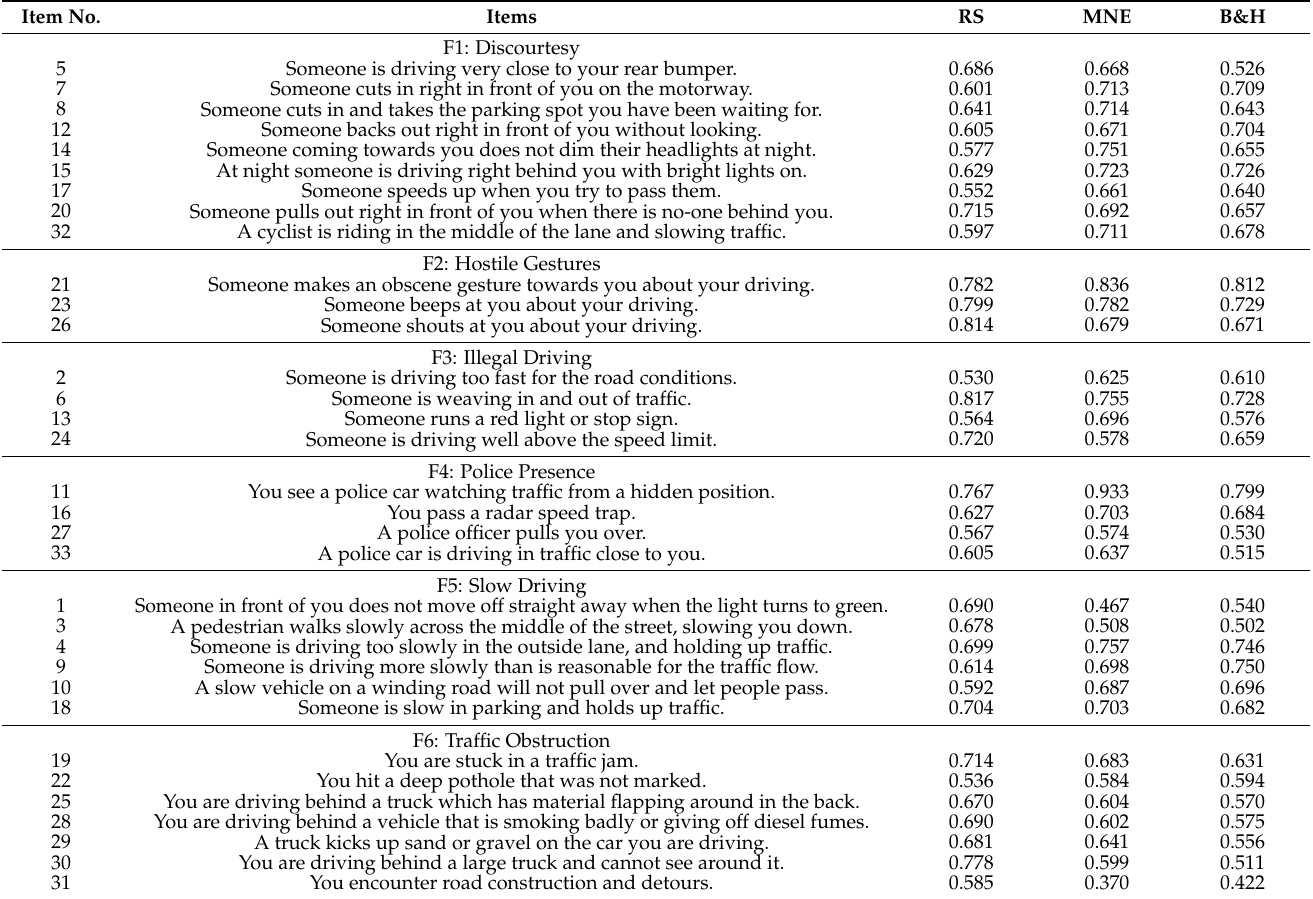
Table 4. Standardized factor loadings for the original DAS in RS, MNE and